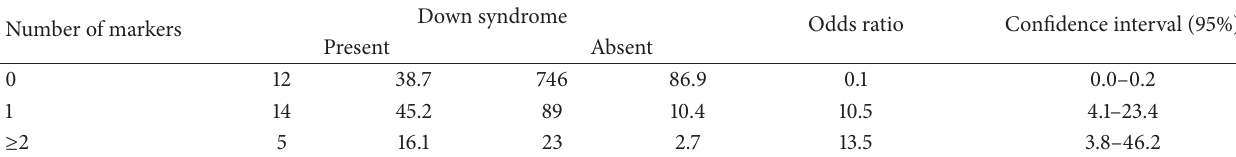
Table 6: Odds ratios between the number of ultrasound markers and Down